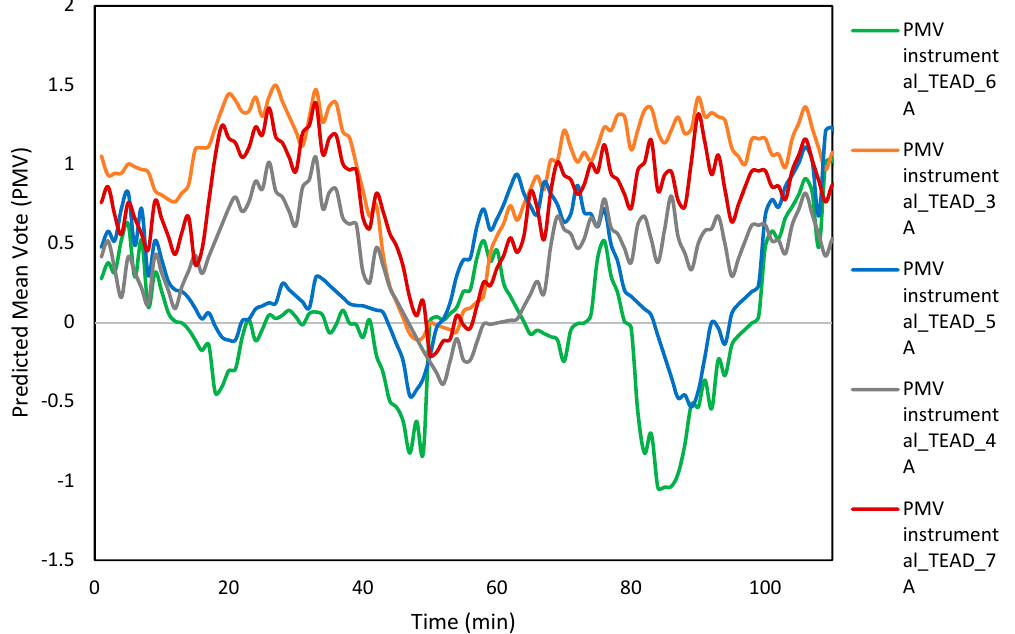
Figure 11. Variation in Predicted Mean Vote (PMV) at different operating powers.